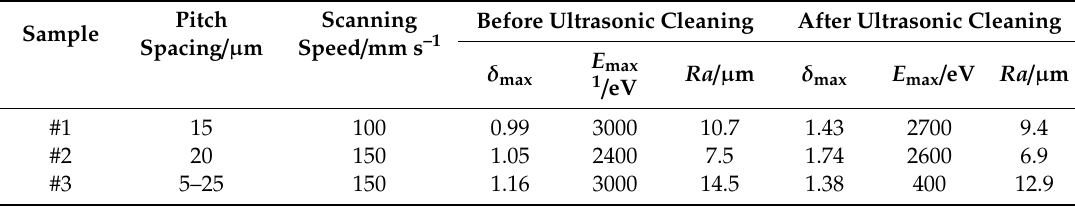
Table 1. Laser parameters for aluminum alloy